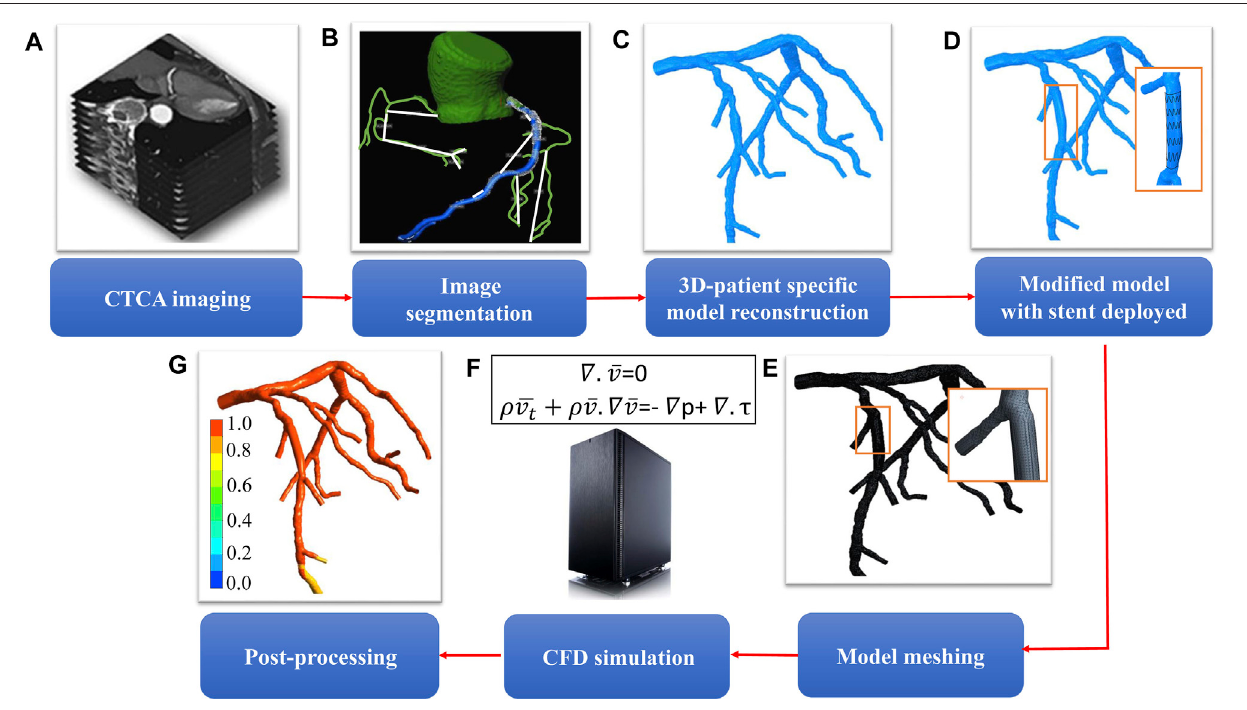
FIGURE 1 | Work fl ow for determining the hemodynamic effect of revascularization using virtual stenting and noninvasive FFR B (A) acquisition of CTCA images (B) segmentationofacquiredimages (C) 3Dreconstructionofpatient-speci fi ccoronaryarterytree (D) modelmodi fi cationtoreplacethestenoticregionwithavirtualstentof desired geometric characteristics (E) mesh generation to discretize the 3D model (F) solution of mass and momentum conservation equations to simulate blood fl ow in coronary arteries (G) post-processing to obtain non-invasive FFR B .